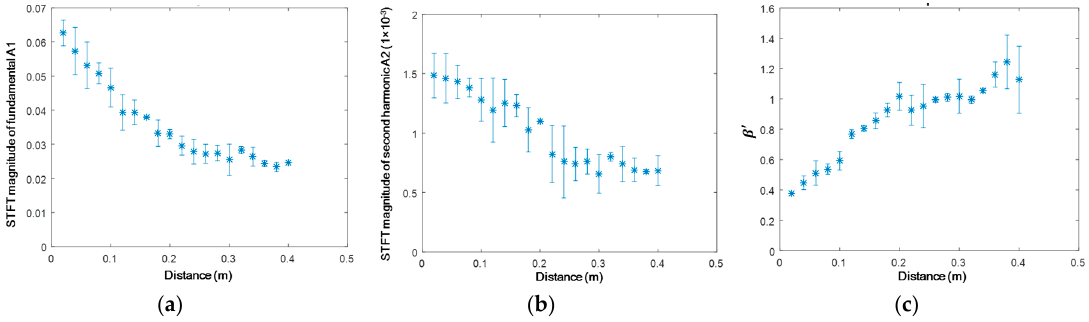
Figure 11. Magnitudes of the S 0 -S 0 mode pair (0.4 MHz mm–0.8 MHz mm) extracted through STFT in four repeated experiments ( a ) fundamental mode A1; ( b ) second harmonic mode A2; and ( c ) A2/(A1) 2 .